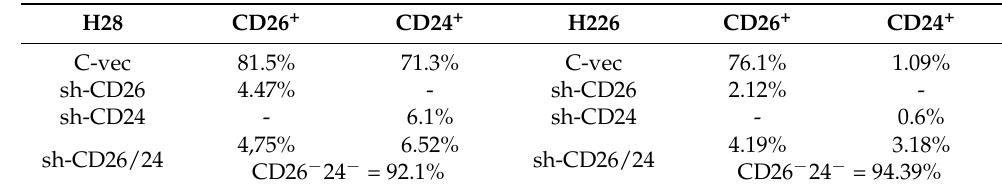
Table 1. Expression of CD24 and CD26 was down-regulated in MMs using shRNA lentiviral particles. The results are based on flow cytometry analysis.